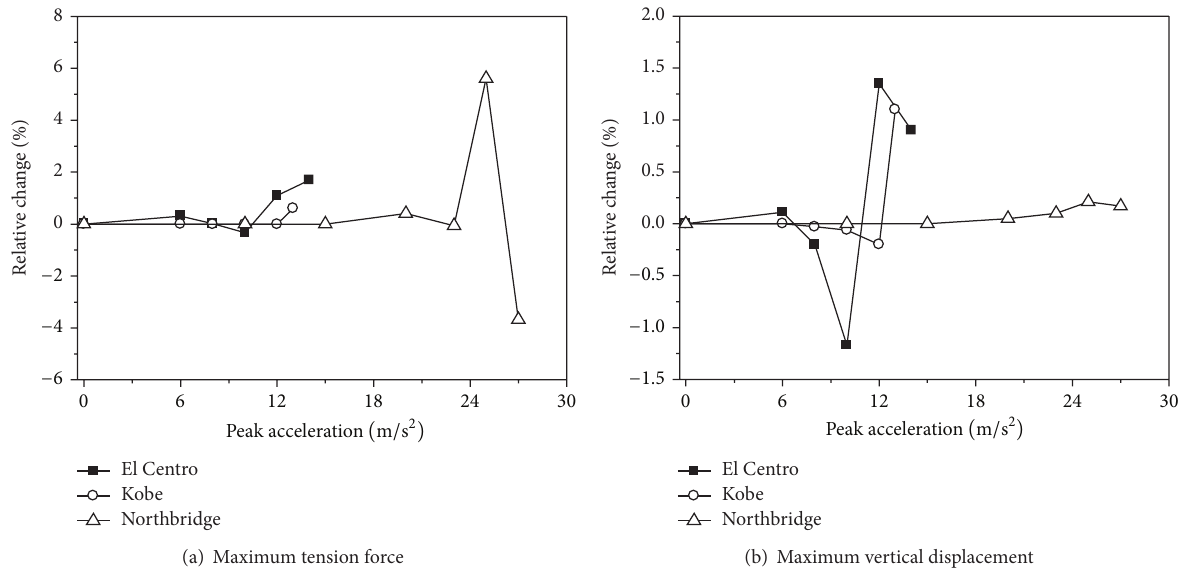
Figure 7: Relative changes of the ground wire’s maximum